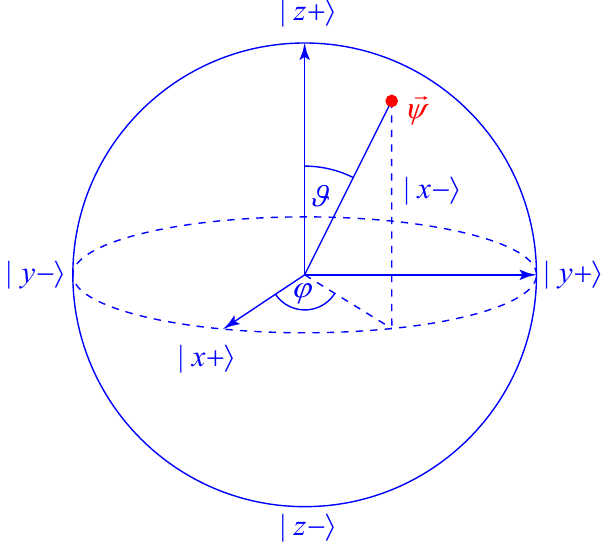
Figure 8: The Bloch sphere representation of a qubit. The quantum state is represented as a point (cid:126)ψ on the surface of a unit